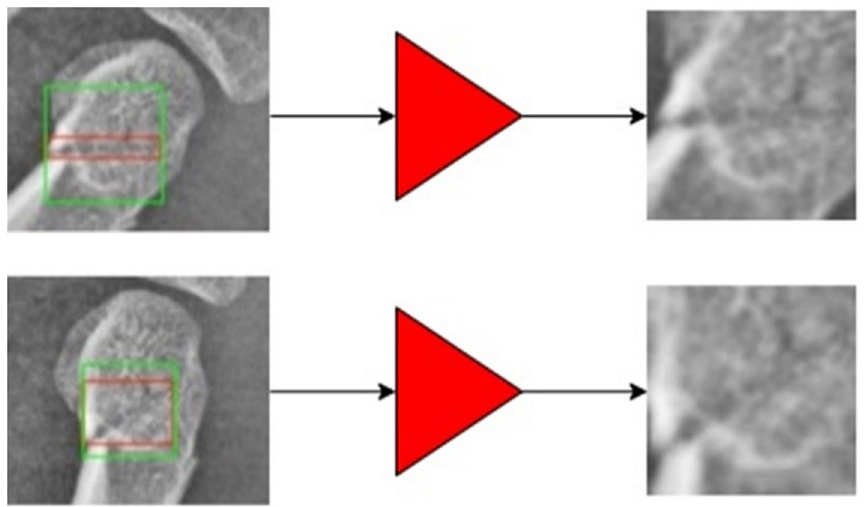
Figure 7. Feature ambiguity in fracture detection was countered in the Feature Ambiguity Mitigate Operator (FAMO) method. On the left, the annotated box was adjusted by expanding its short side (upper left) to the same length as its long side and making a square box (lower left). Thus, the image was not distorted nor